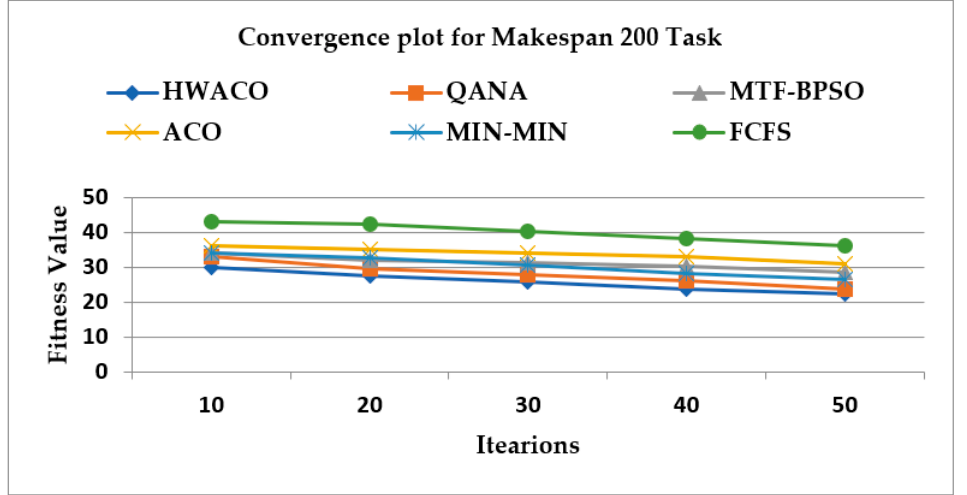
Figure 4. The convergence plot for makespan of 200 tasks.